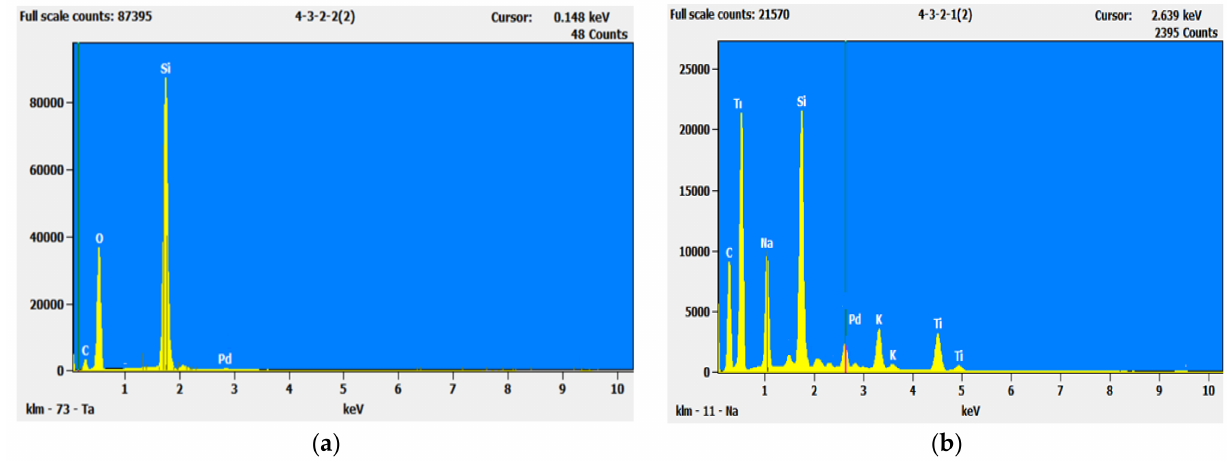
Figure A1. EDX spectra of ( a ) silica SBA-15 and ( b ) titanosilicate ETS-10.